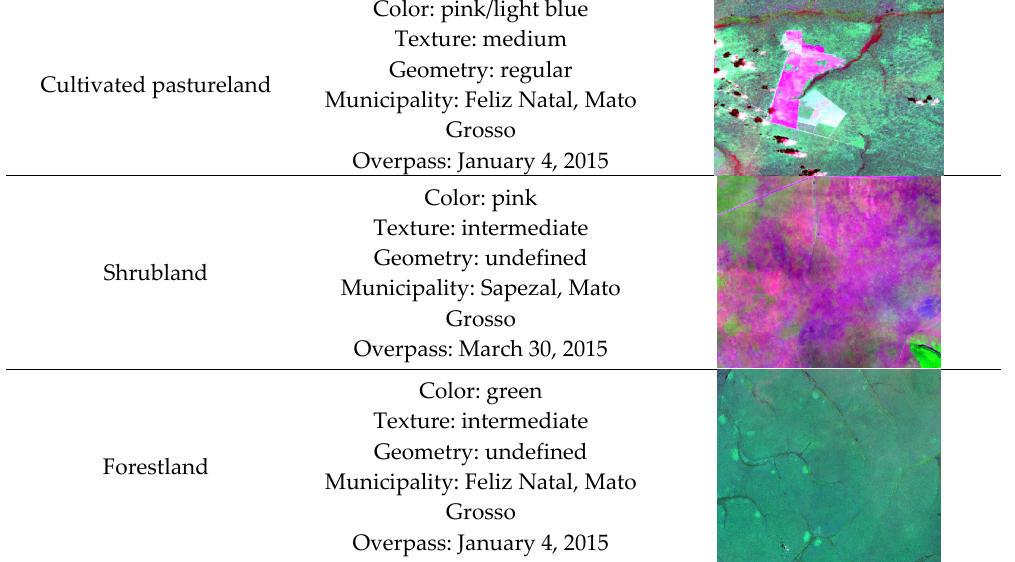
Figure 9. Interpretation key for the Landsat-8 OLI color composites of bands 4, 5, and 6 for most representative land use and land cover classes found in the Mato Grosso State (croplands, pasturelands, Cerrado shrublands, and primary forestlands).